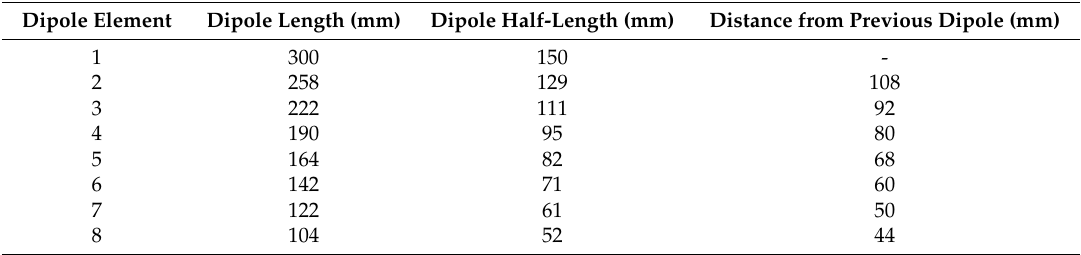
Table 3. Dimensions of each dipole